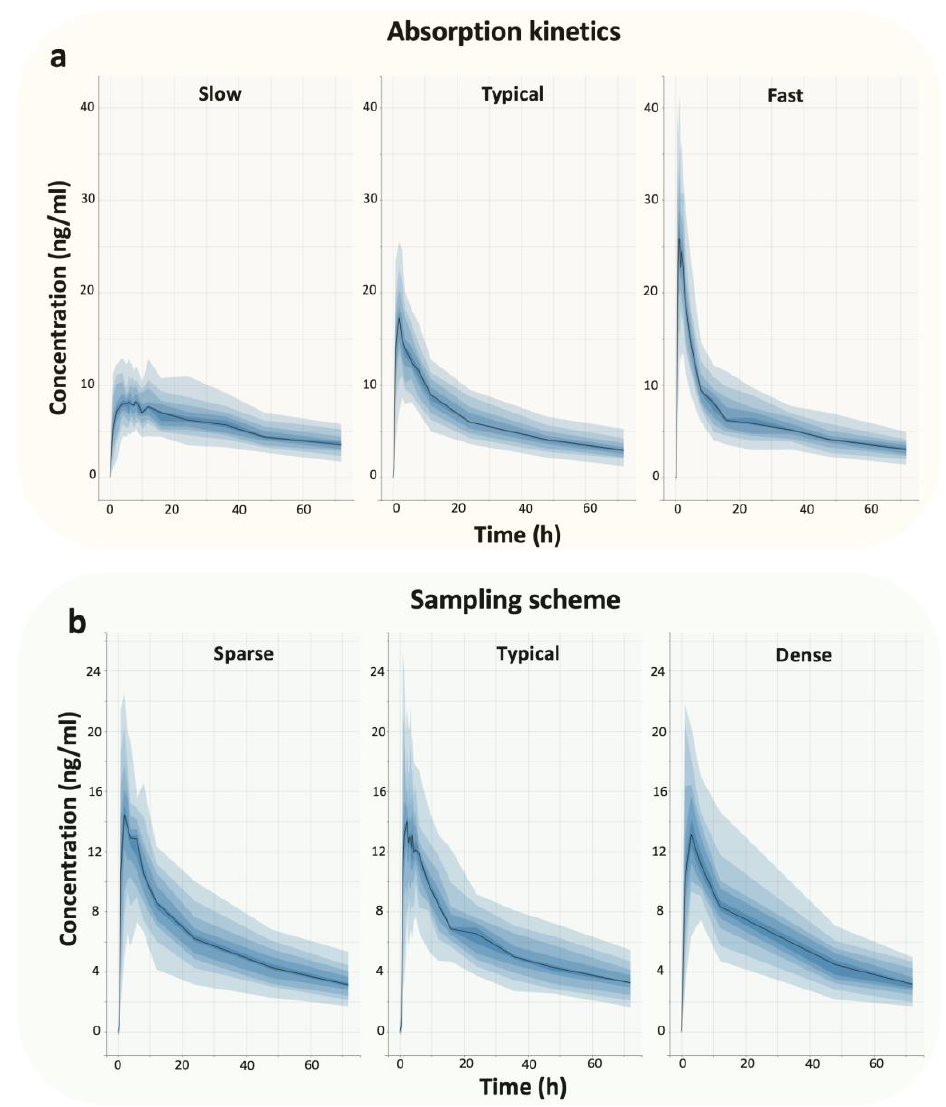
Figure 5. Simulated concentration vs. time profiles of donepezil. ( a ) A typical sampling scheme is used for the three different absorption kinetics (slow (0.5×), typical (1×), and fast (2×)), ( b ) Three different sampling schedules (sparse, typical, and dense) are shown in the case of typical (1×) absorption kinetics. The terms 0.5×, 1×, and 2× refer to the number of times the absorption rate constant used in simulations is greater or less than the one observed in actual data. All other pharmacokinetic parameters were kept equal to those found from population pharmacokinetic modeling. A number of 1000 subjects was simulated in each case.